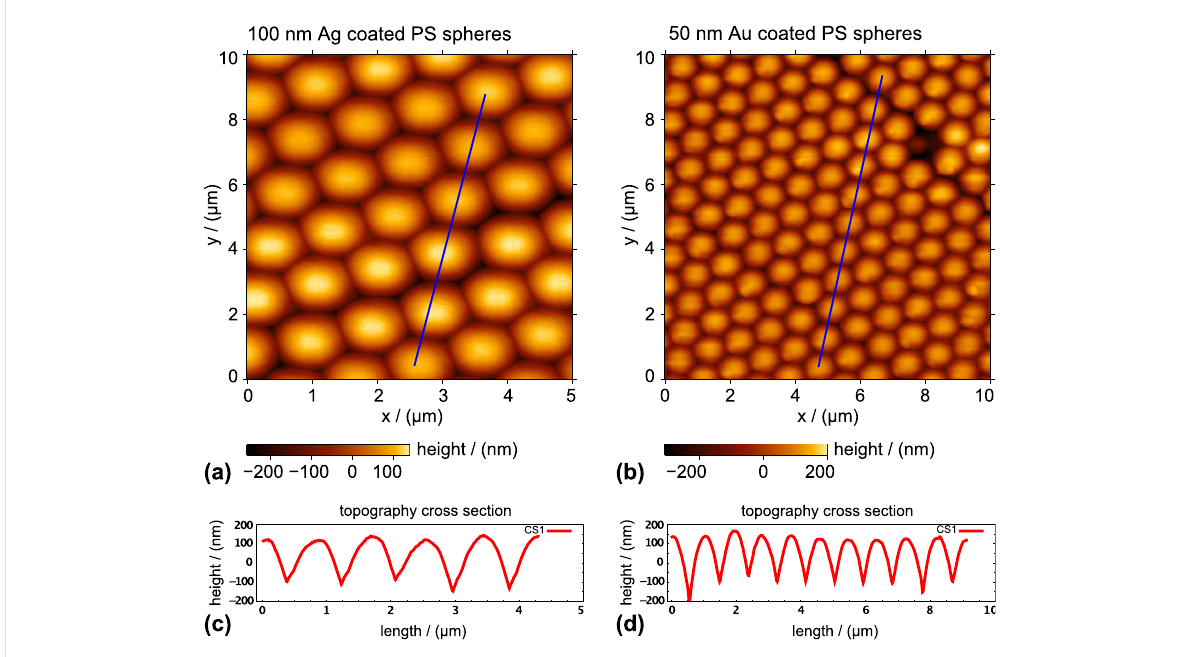
Figure 2: AFM topography images of coated beads (a) and coated hemispheres (b), both fabricated using PS spheres of 1 μ m diameter. The plots of (c) and (d) are cross sections of lines marked in the topography images.